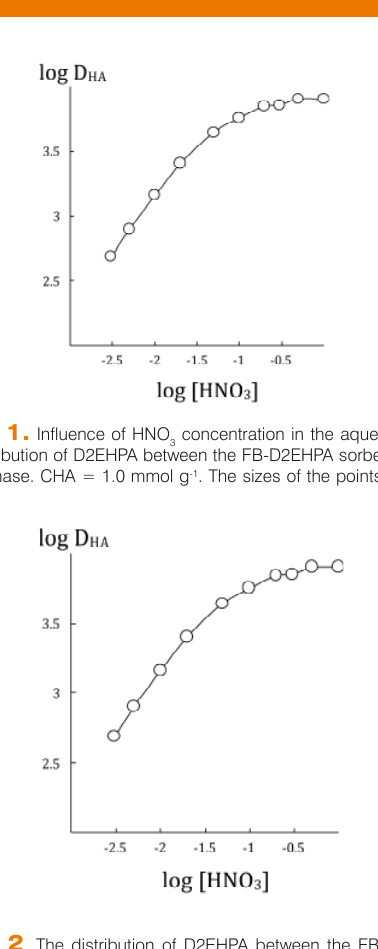
solutions. The sizes of the points 3